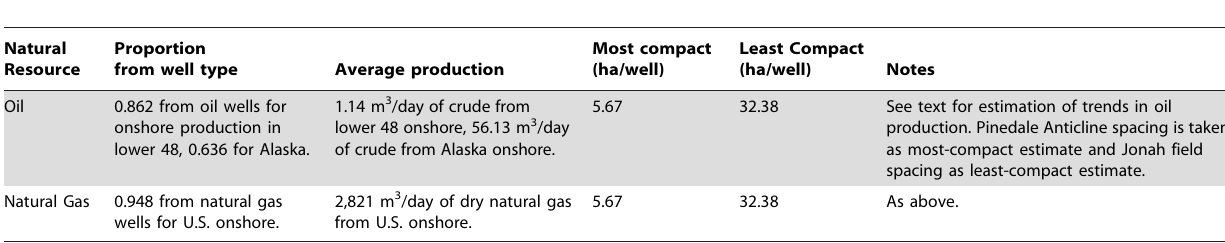
Table 3. Land-use intensity of oil and natural gas production.